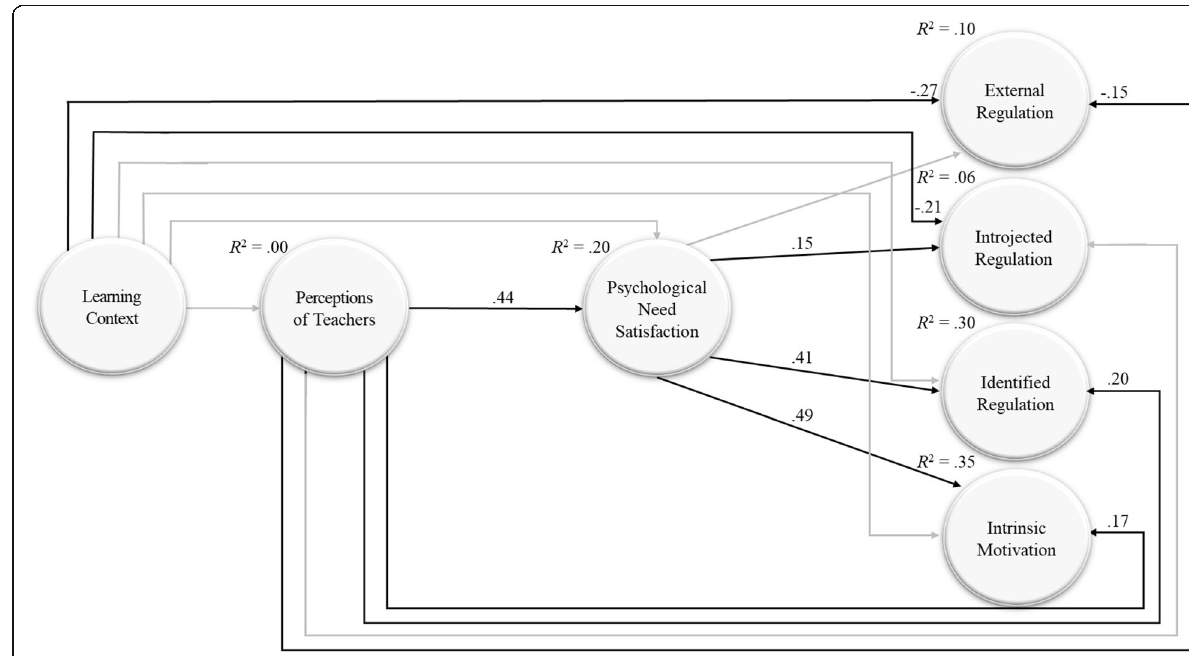
Fig. 2 Results of structural equation model that tests the effect of program delivery context on students ’ experience based in self-determination theory. Standardized solutions reported. Significant paths are in black and non-significant paths are in gray. Indirect associations are not depicted but were included in the analyses. The effects for gender and race/ethnicity were tested but were not significant and were excluded from the final model. RMSEA = .07; p close = .05; TLI = .95; CFI =